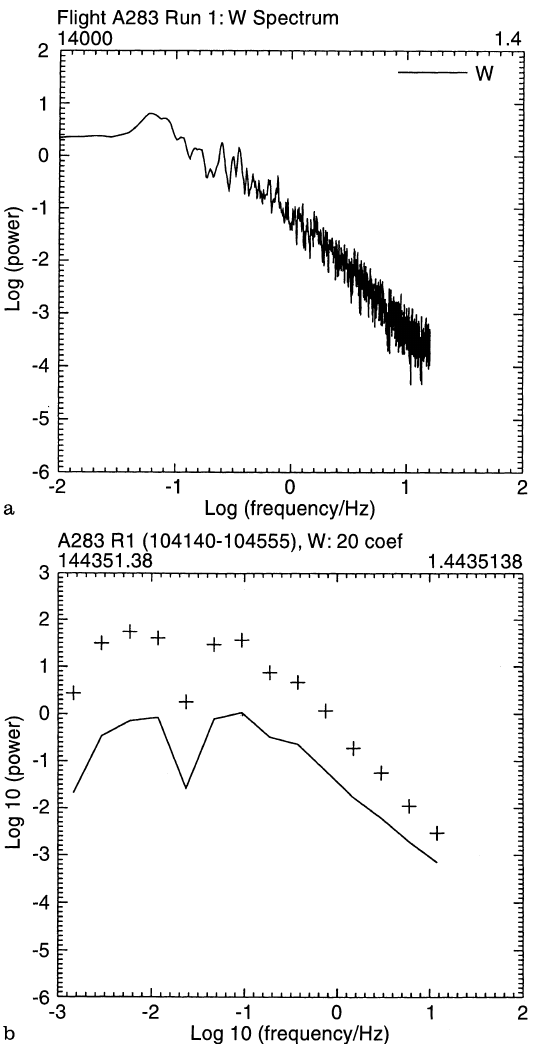
Fig. 8. As in Fig. 7 but for the data shown in Fig. 6 (A290